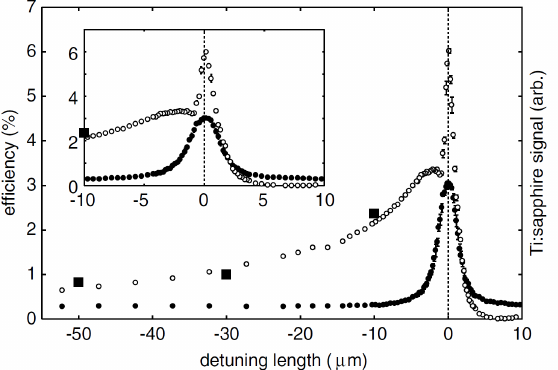
Figure 1. FEL efficiencies (open circles) and Ti:sapphire signals (solid circles) as a function of detuning length at the JAERI-FEL experiment. The enlargement around δ L = 0 is also shown. The symbols without error bars have an error less than their size. The absolute vertical scale was calibrated by an average energy loss of the electron beam over an entire macropulse (solid squares) at several detuning lengths [10].